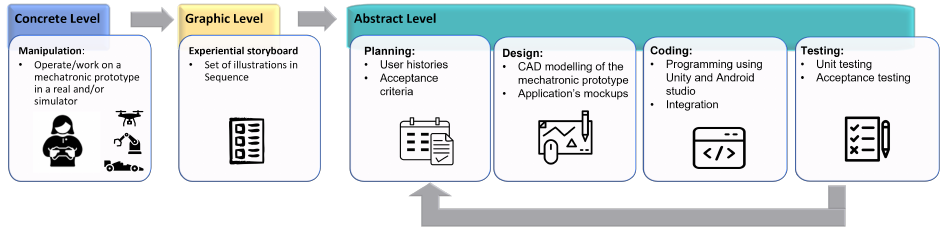
Figure 3. MeDARA for mobile app development.